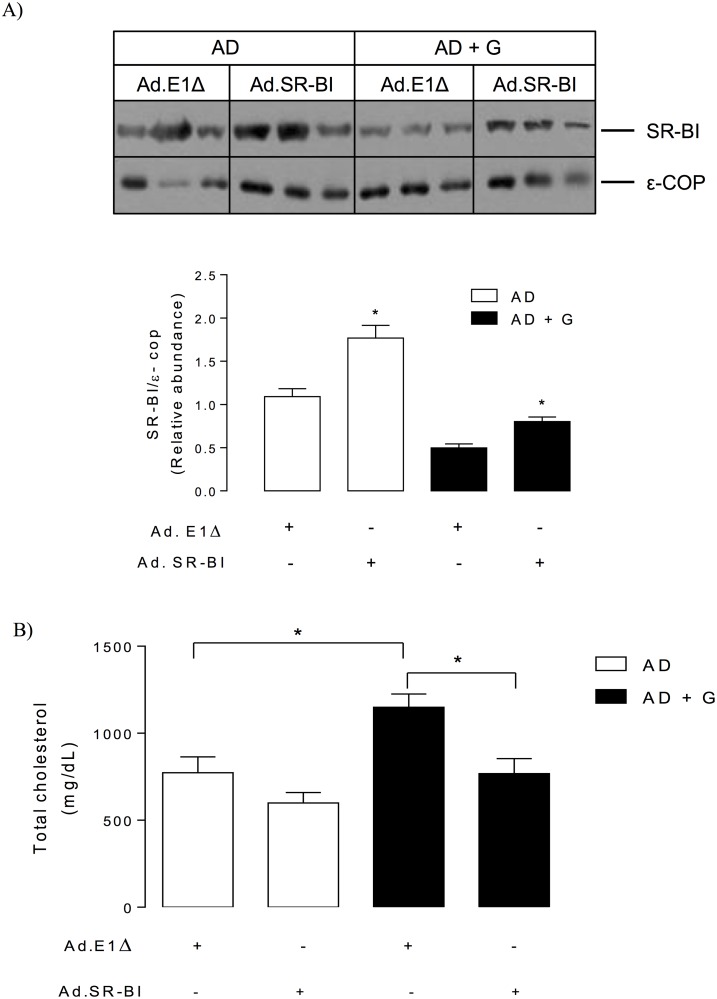
Effect of hepatic SR-BI overexpression on plasma cholesterol in gugulipid-treated atherogenic diet-fed male ApoE KO mice.(A) Western analysis (upper) and quantitation (lower) of hepatic SR-BI and (B) plasma total cholesterol levels in control atherogenic diet-fed and gugulipid-treated atherogenic diet-fed mice infected with adenovirus encoding murine SR-BI (Ad.SR-BI) or control adenovirus (Ad.E1Δ). AD: atherogenic diet; G: gugulipid. Two independent experimental sets were used, n = 6 in each. Values represent mean ± SD. *P<0.05.